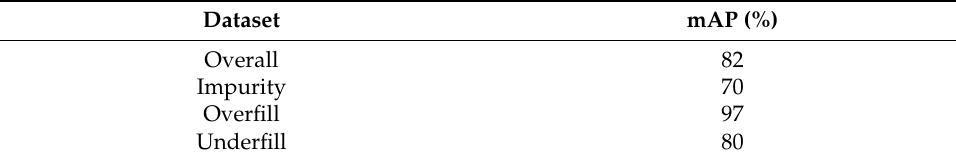
Table 5. Validation mAP on different